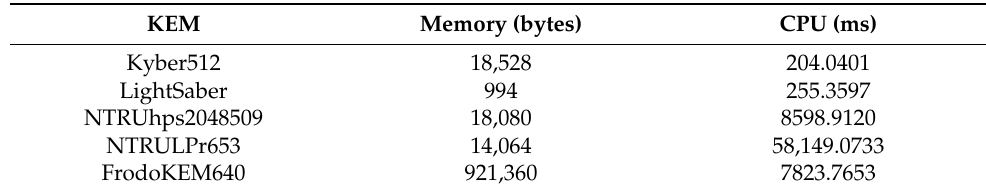
Table 12. Summary of the memory and CPU usage for each of the KEMs involved. For the CPU usage, we present the total amount of time the KEMs use it. KEM CPU (ms)